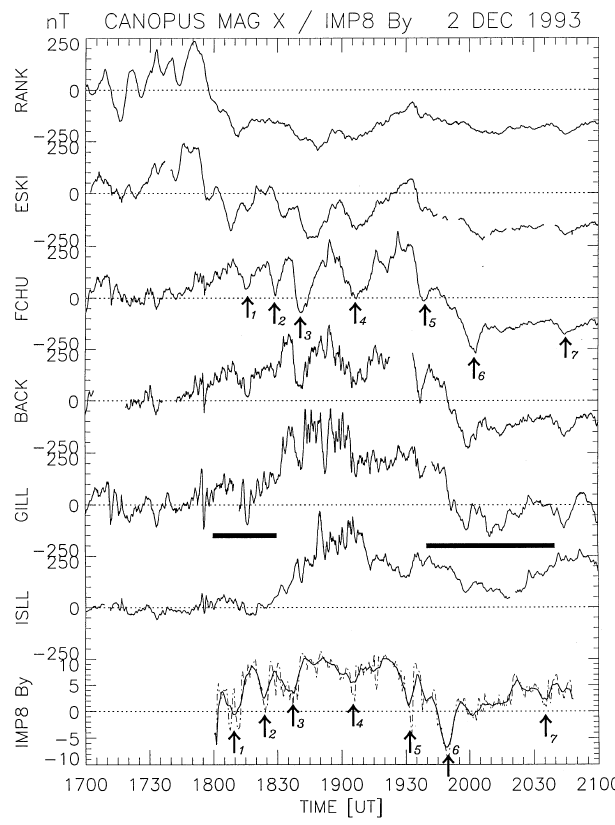
Fig. 5. The X -component ground magnetic perturbations measured by the CANOPUS north-south magnetometer array. The bottom trace is the smoothed ( solid ) and unsmoothed ( broken ) IMP-8 30-s IMF B component. The arrows indicate corresponding phases of y long-period variations of IMF B component and poleward-pro- y gressing magnetic disturbances (DPY currents). The horizontal bars indicate two pulsation periods discussed in